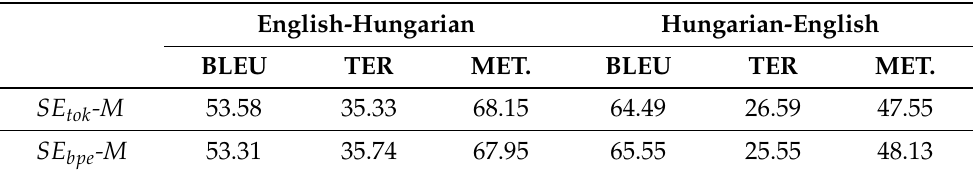
Table 5. Results of the automated evaluations for two additional systems without alignment features and with maximum coverage for English ↔ Hungarian.